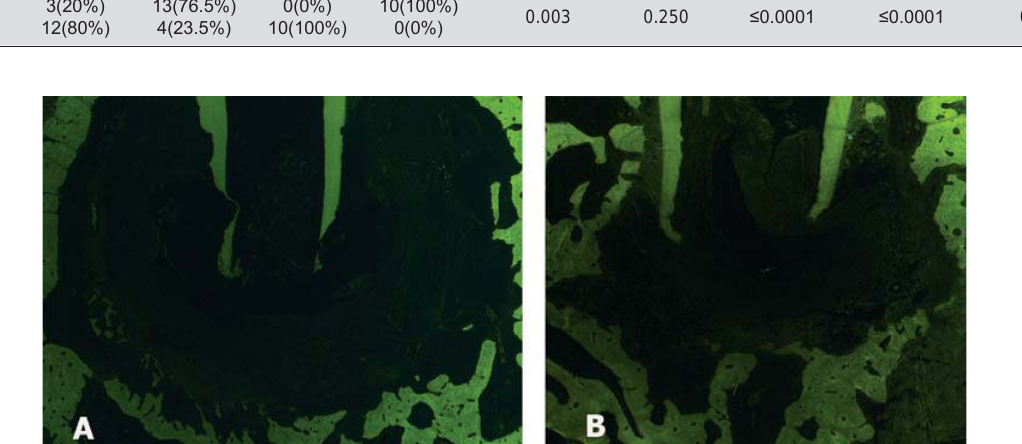
Figure 3- Photomicrographs of microscopic sections representing the 4 groups evaluated, 90 days after the endodontic treatment: (A) (cid:53)(cid:72)(cid:83)(cid:85)(cid:72)(cid:86)(cid:72)(cid:81)(cid:87)(cid:68)(cid:87)(cid:76)(cid:89)(cid:72)(cid:3)(cid:83)(cid:75)(cid:82)(cid:87)(cid:82)(cid:80)(cid:76)(cid:70)(cid:85)(cid:82)(cid:74)(cid:85)(cid:68)(cid:83)(cid:75)(cid:86)(cid:3)(cid:82)(cid:73)(cid:3)(cid:87)(cid:75)(cid:72)(cid:3)(cid:70)(cid:82)(cid:81)(cid:89)(cid:72)(cid:81)(cid:87)(cid:76)(cid:82)(cid:81)(cid:68)(cid:79)(cid:3)(cid:74)(cid:85)(cid:82)(cid:88)(cid:83)(cid:15)(cid:3)(cid:43)(cid:40)(cid:16)(cid:54)(cid:87)(cid:68)(cid:76)(cid:81)(cid:72)(cid:71)(cid:3)(cid:68)(cid:81)(cid:71)(cid:3)(cid:82)(cid:69)(cid:86)(cid:72)(cid:85)(cid:89)(cid:72)(cid:71)(cid:3)(cid:88)(cid:81)(cid:71)(cid:72)(cid:85)(cid:3)(cid:192)(cid:88)(cid:82)(cid:85)(cid:72)(cid:86)(cid:70)(cid:72)(cid:81)(cid:70)(cid:72)(cid:3)(cid:80)(cid:76)(cid:70)(cid:85)(cid:82)(cid:86)(cid:70)(cid:82)(cid:83)(cid:92)(cid:3)(cid:11)(cid:43)(cid:40)(cid:15)(cid:3)(cid:61)(cid:72)(cid:76)(cid:86)(cid:86)(cid:15)(cid:3)